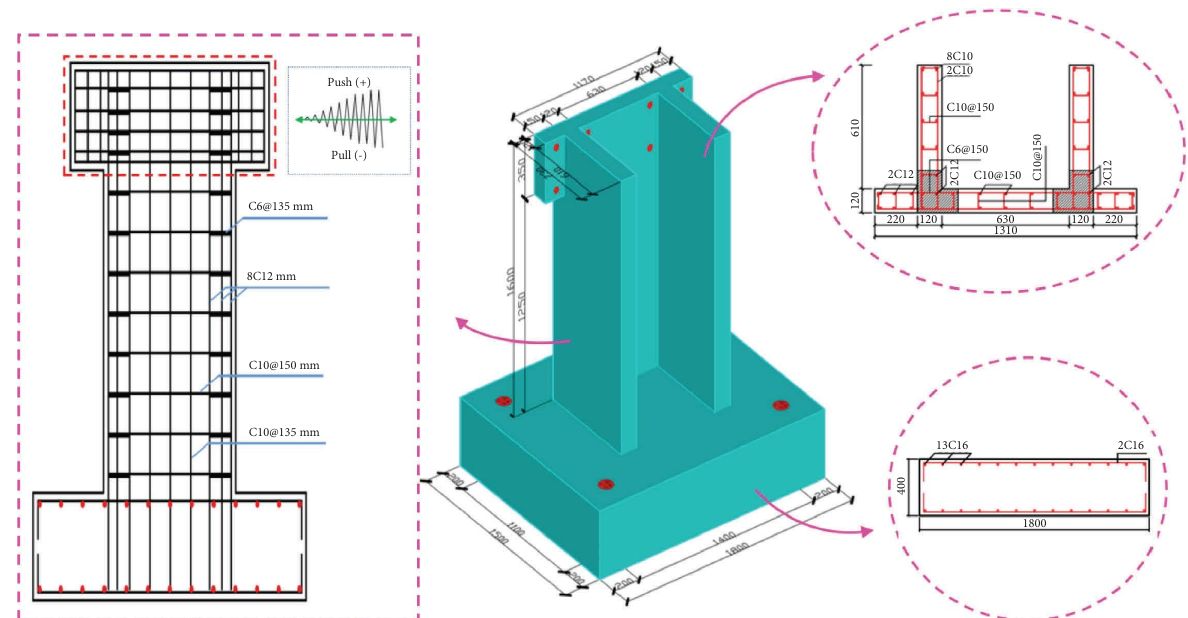
Figure 5: URC-Y shear wall specimens and reinforcement